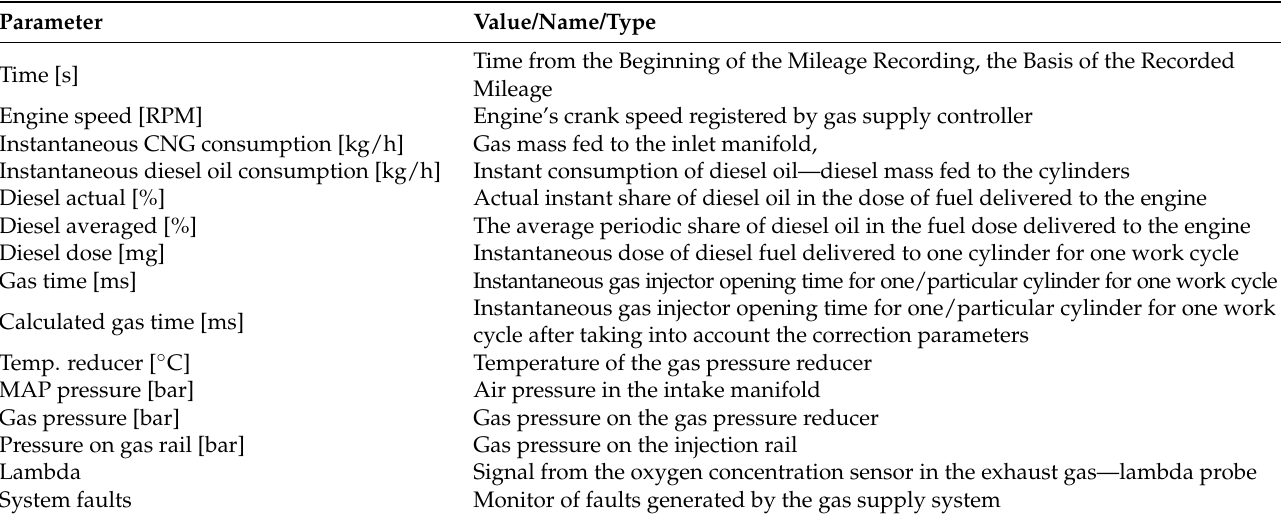
Table 3. Selected parameters characterizing the operation of the gas fuel supply system (manufac- turer’s data).